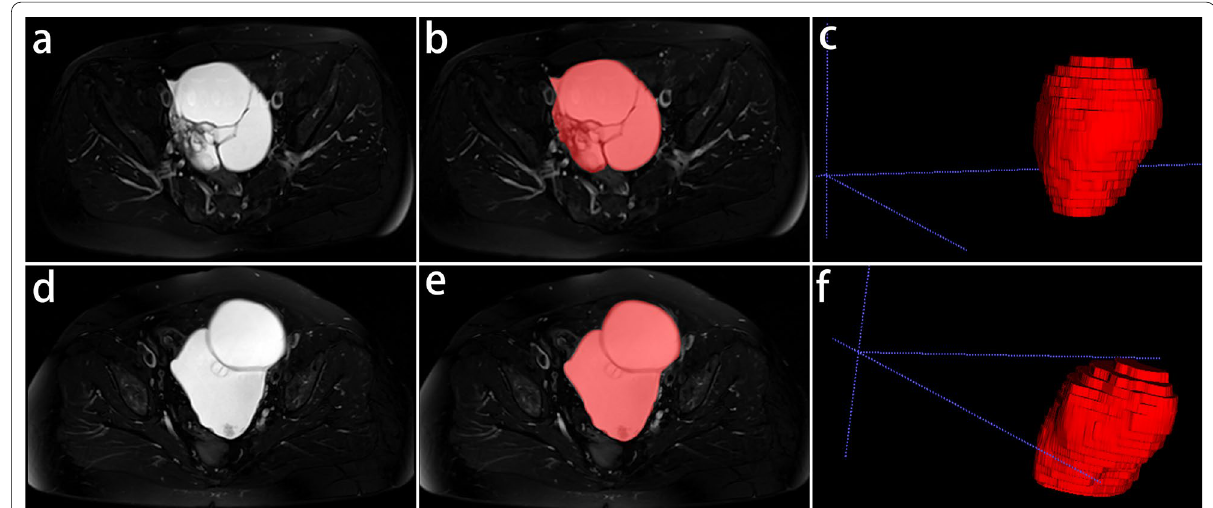
Fig. 2 Two representative examples of volumes of interest (VOIs) segmentation of benign and borderline EOTs in axial fat-suppressed T2-weighted images. a – c A 50-year-old woman with a right benign mucinous cystadenoma; d – f a 60-year-old woman with a left borderline mucinous cystadenoma; a , d the original images; b , e the VOIs of ovarian masses showing in red; c , f 3D renderings of the